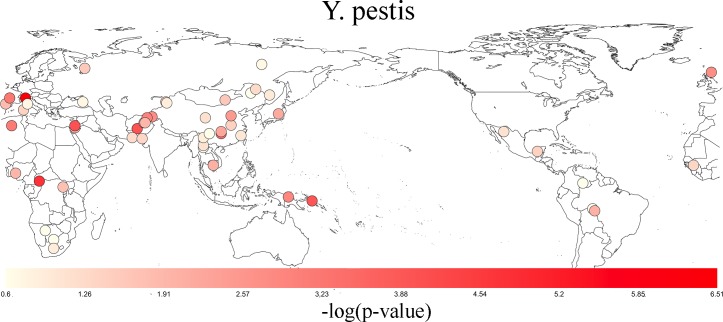
Worldwide selection of Yersinia pestis.A p-value for selection in human genes that interact with Yersinia pestis was produced for each population. Each population is represented by a colored circle on the map. The significance for selection is portrayed by a white to red gradient with lighter colors representing higher p-values and brighter red colors representing lower p-values. Only SNPs within genes that interact with Yersinia pestis were included in determining the p-values of selection for each population. These SNPs were filtered for LD. The most significant p-values were found in Europe, Central South Asia, and Africa.